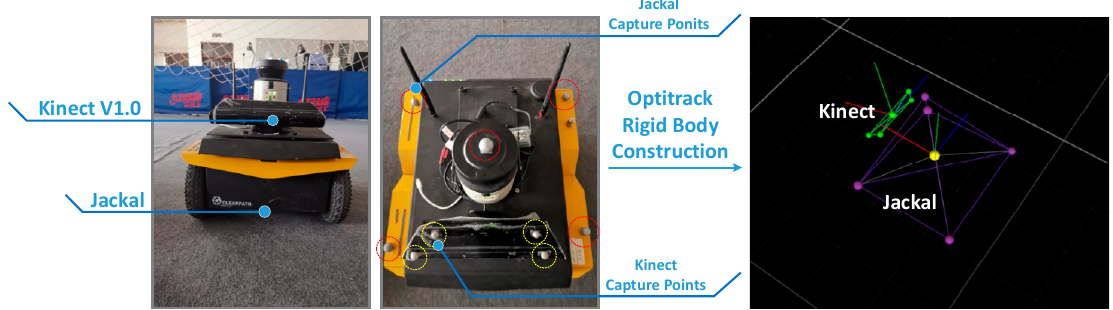
Figure 18. Experimental platform and capture of rigid body construction in Optitrack.